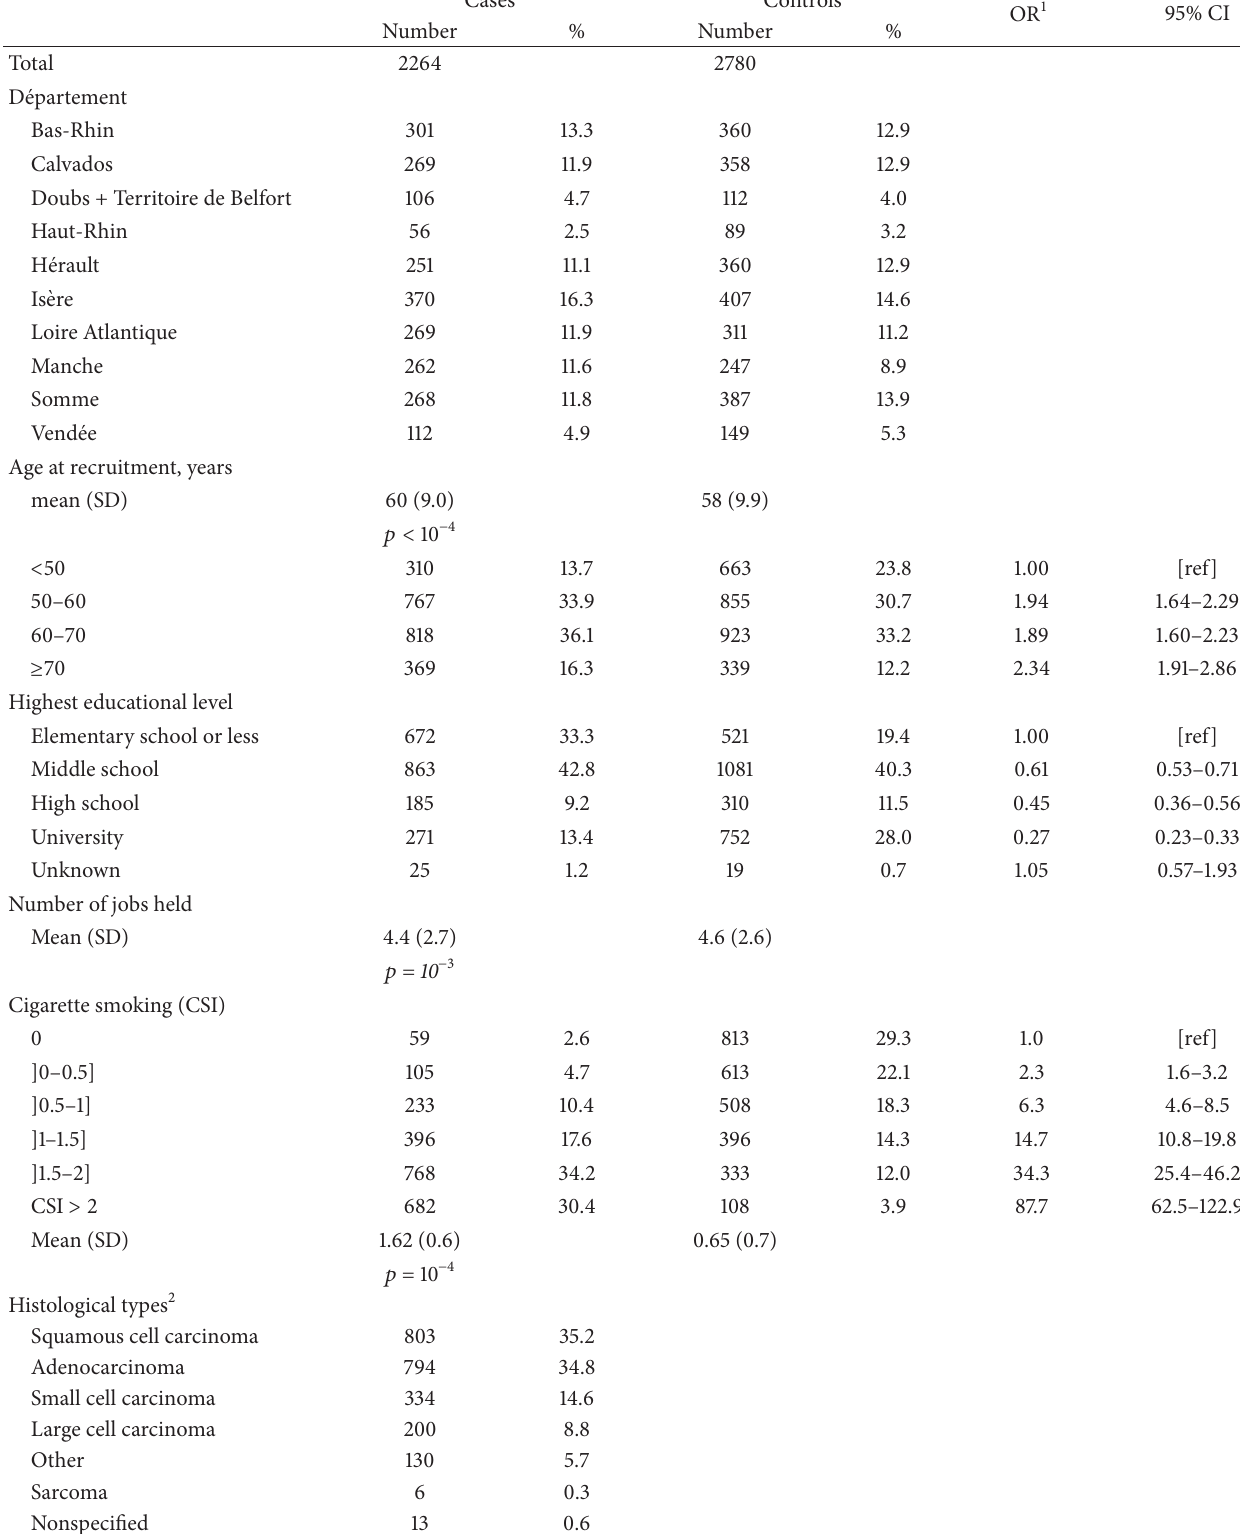
Table 1: Selected characteristics of the male study population by case-control